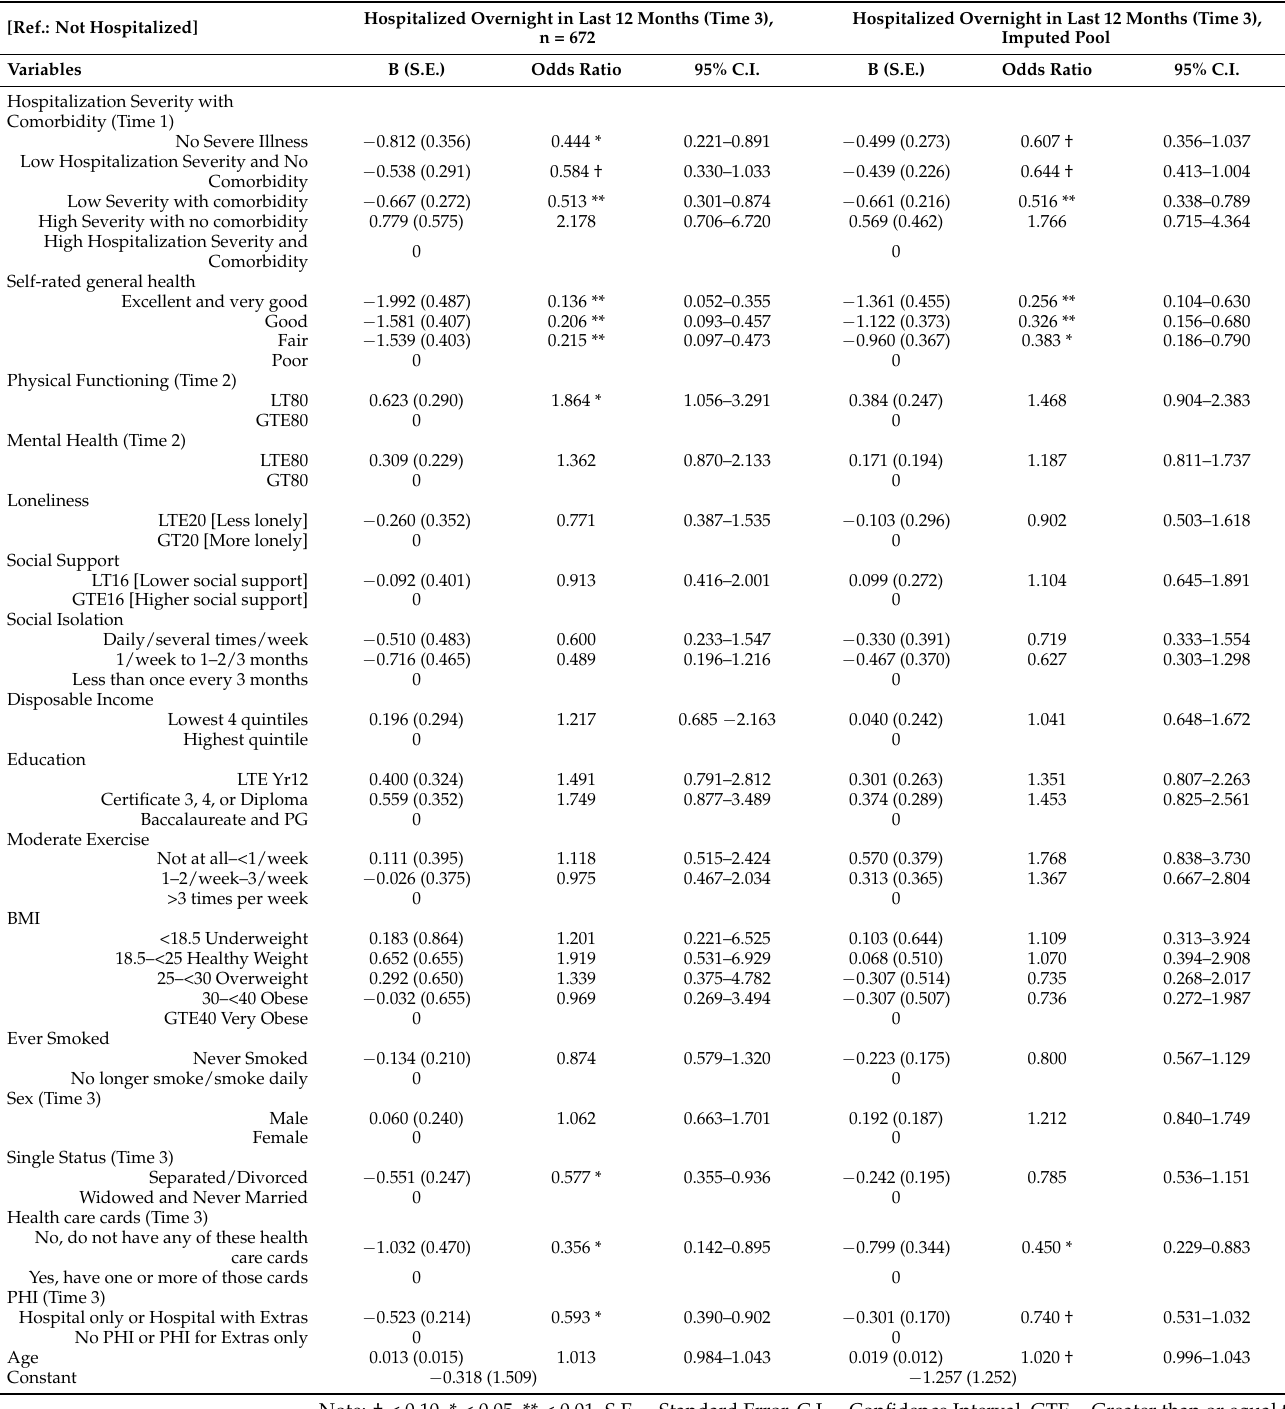
Table 2. The logistic regression results on having overnight hospitalization at Time